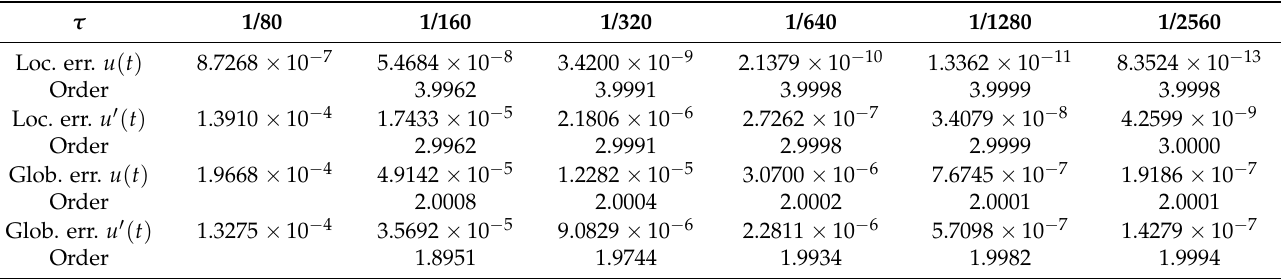
Table 1. Local and global errors and orders for problem (2) with RN2.